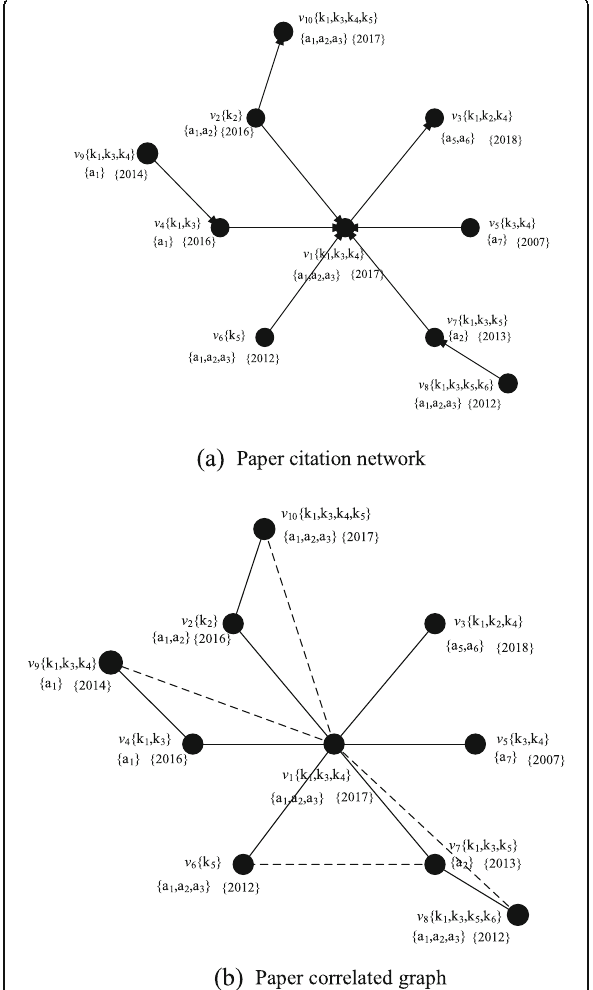
Fig. 2 a and b are part of the paper citation network and the paper correlated graph,